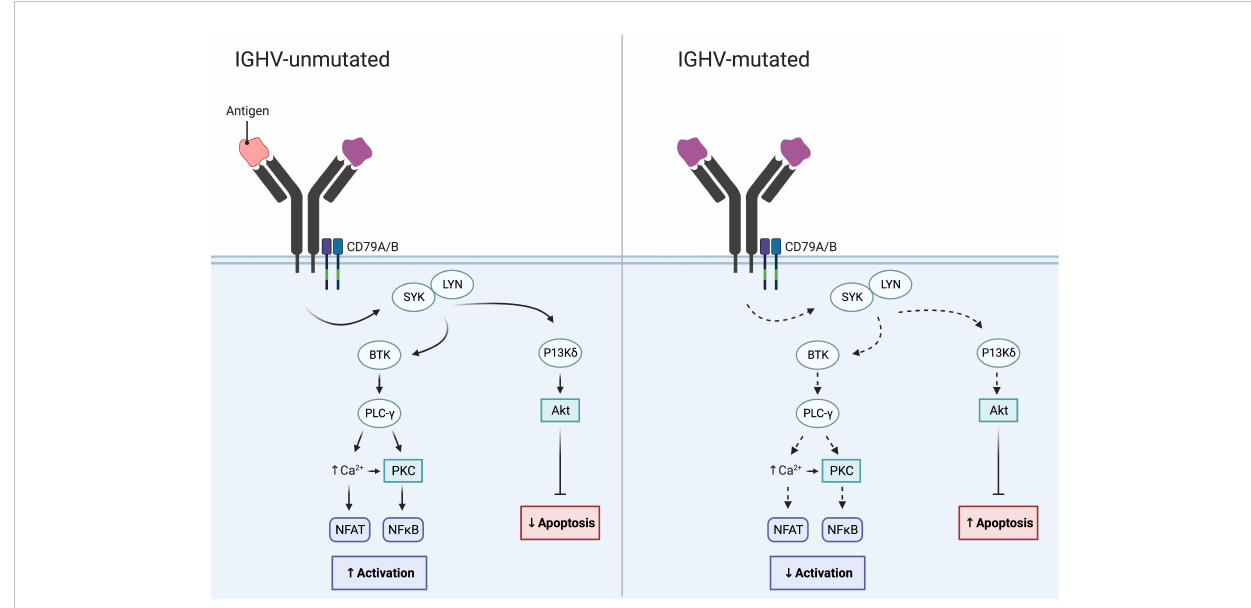
FIGURE 2 IGHV gene SHM status in CLL and its impact on BcR signaling. While the BcR in IGHV-unmutated CLL often displays polyreactive antigen af fi nity resulting in increased BcR signaling, the BcR of IGHV-mutated CLL demonstrates reduced BcR signaling and reduced NF- k B activation.